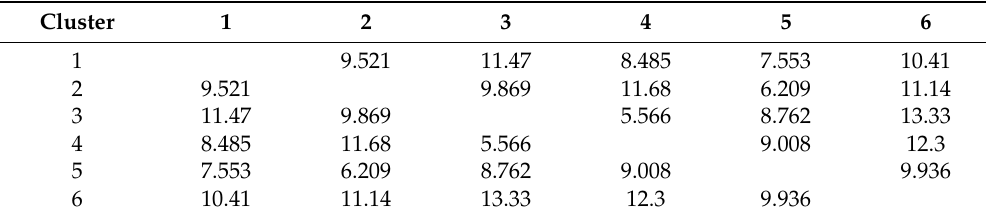
Table 2. Nearest cluster analysis showing Mahalanobis D 2 distance between groups of SSE Amaranths.